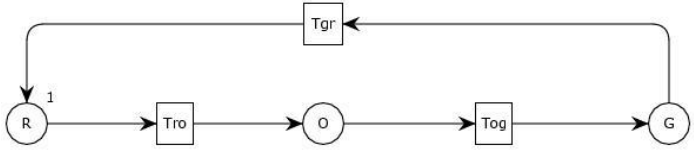
Figure 1 . CPN Model of a Traffic Light System. Figure 1. CPN Model of a Traffic Light